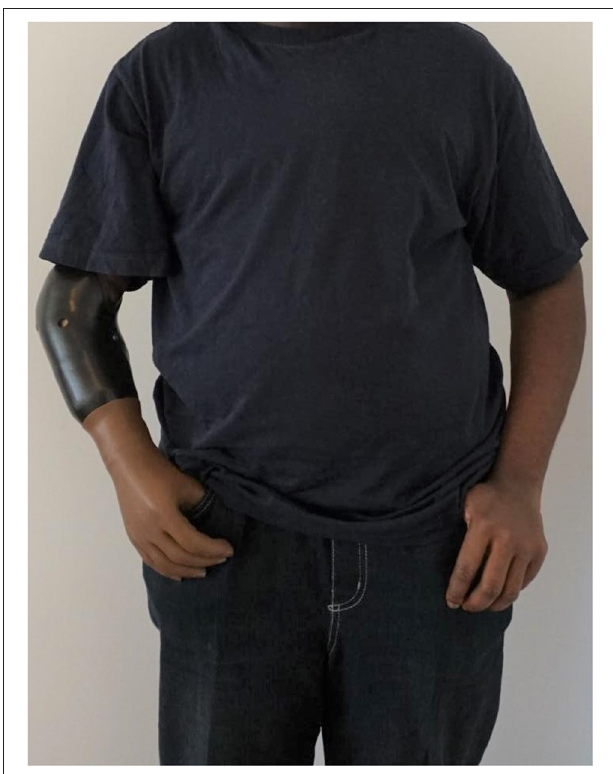
FIGURE 3 | Patient with the final prosthetic fitting 1.5 years after the amputation.